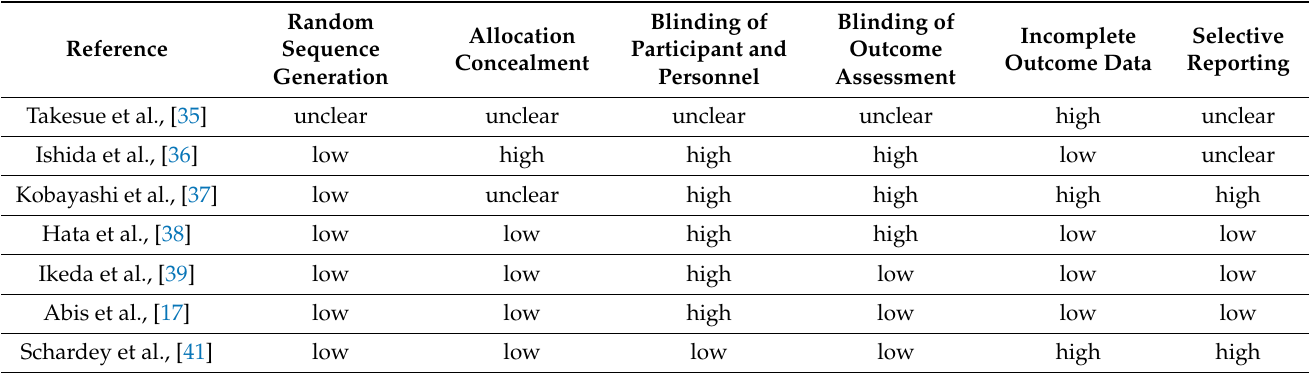
Table 2. Risk of bias within randomized controlled trials included within the